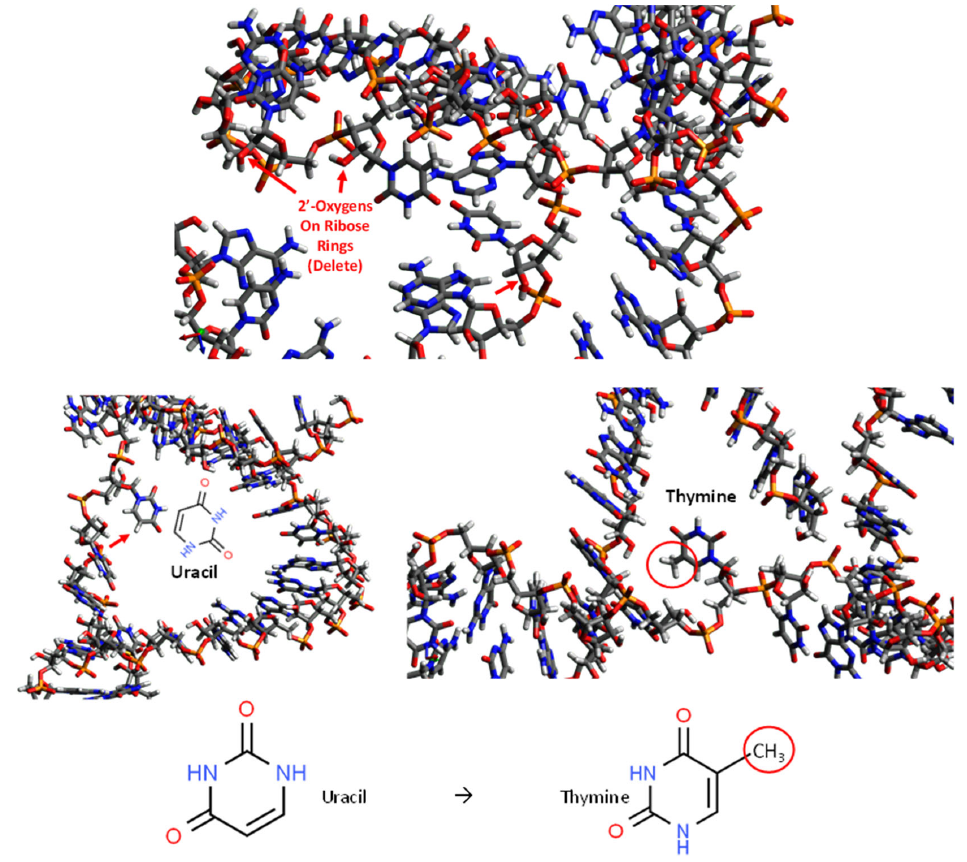
Figure 2. Graphics from Avogadro to illustrate the tedious and error-prone nature of converting generic 3D RNA aptamer structures into their DNA counterparts. The process includes deleting all 2 (cid:48) hydroxyl groups on ribose rings at the 2 (cid:48) oxygen atoms (top panel) and addition of methyl groups to all uracil rings (red arrow at lower left panel) as shown to convert them to thymines (red circled methyl group on thymine lower right